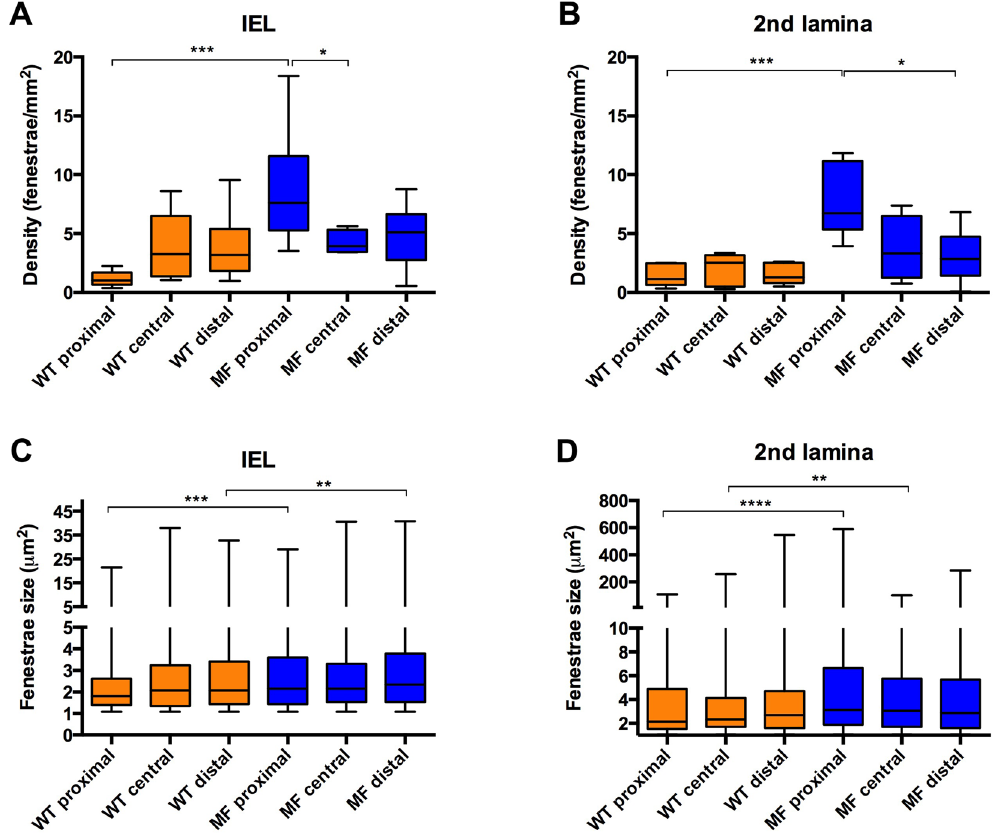
Figure 6. Quantitative analysis of fenestrae in IEL and 2 nd laminae in the longitudinal plane of the ascending aorta. The density of fenestrae in the IEL ( A ) and 2 nd lamina ( B ), and their respective individual fenestrae size ( C and D ) measured at different longitudinal plane locations (proximal, central and distal) of WT (orange) and Marfan (MF, blue) ascending aortae. Statistical significance between groups is indicated by asterisks. Interquartile boxplots with minimum and maximum whiskers. Forty maximal projections were analysed and a total of 6,400 fenestrae were